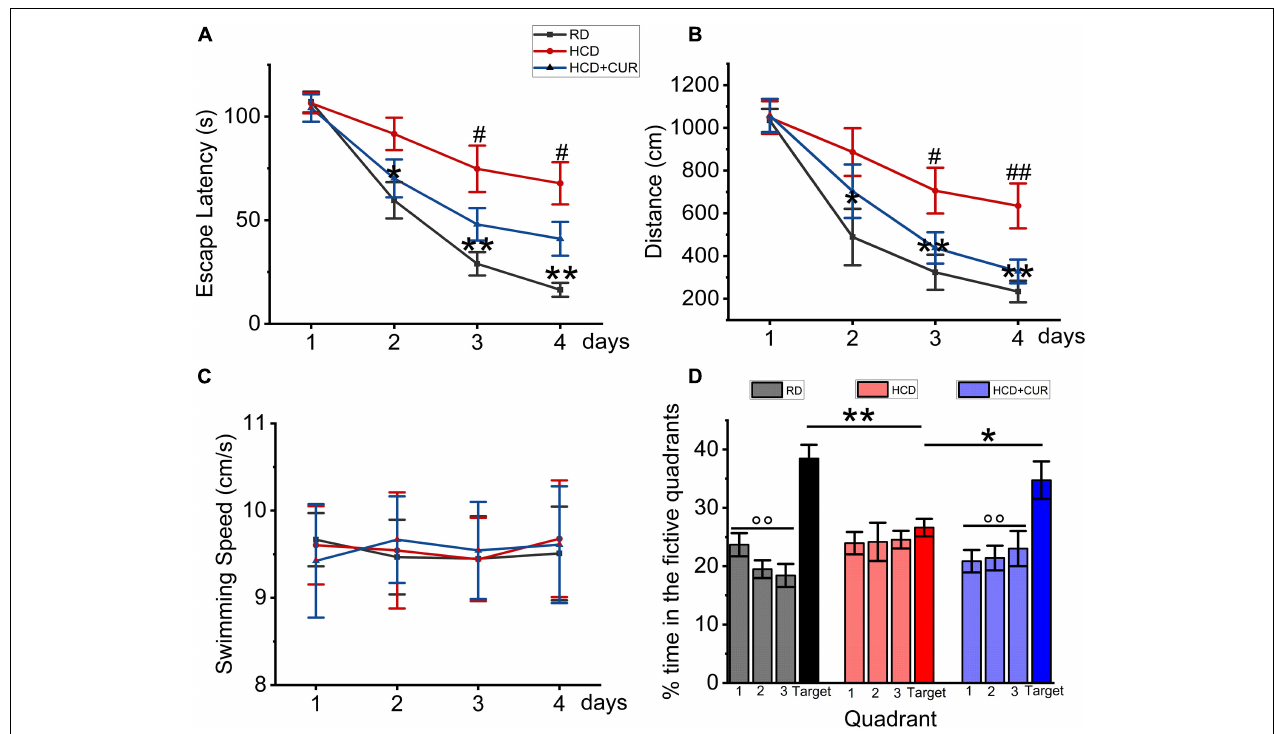
FIGURE 4 | Changes in spatial learning and memory in Morris water maze test in rats. RD, control group; HCD, high cholesterol diet group; HCD + CUR, high cholesterol diet receiving a daily dose of 200 mg/kg body weight curcumin by gavage for 4 weeks. Carotid injury was induced by an air-drying endothelial denudation method at the end of the second week. (A) Comparison of mean escape latencies to platform during four training days; data are expressed as mean ± SE, n = 10 for each group. * P < 0.05, ** P < 0.01, vs. control group. # P < 0.05, vs. HCD group. (B) Comparison of mean swimming distances during four training days; Data are expressed as mean ± SE, n = 10 for each group. * P < 0.05, ** P < 0.01, vs. control group. # P < 0.05, ## P < 0.01, vs. HCD group. (C) Comparison of swimming speed during 4 training days; Data are expressed as mean ± SE, n = 10 for each group. (D) Comparison of the percent of searching time spent in the quadrant where the platform was removed for probe trial. Data are representative of two independent experiments and are expressed as mean ± SE, n = 10 for each group. * P < 0.05; ** P < 0.01. ◦◦ P < 0.01, vs. target